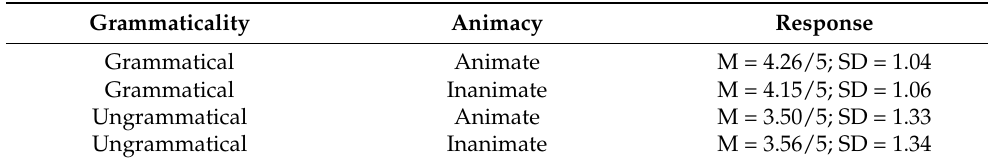
Figure 2. Distribution of acceptance (i.e., response) of grammatical and ungrammatical items accord- ing to animacy in the Spanish AJT. Table 8. Distribution of acceptance of grammatical and ungrammatical items with mean and standard deviation according to animacy in the Spanish